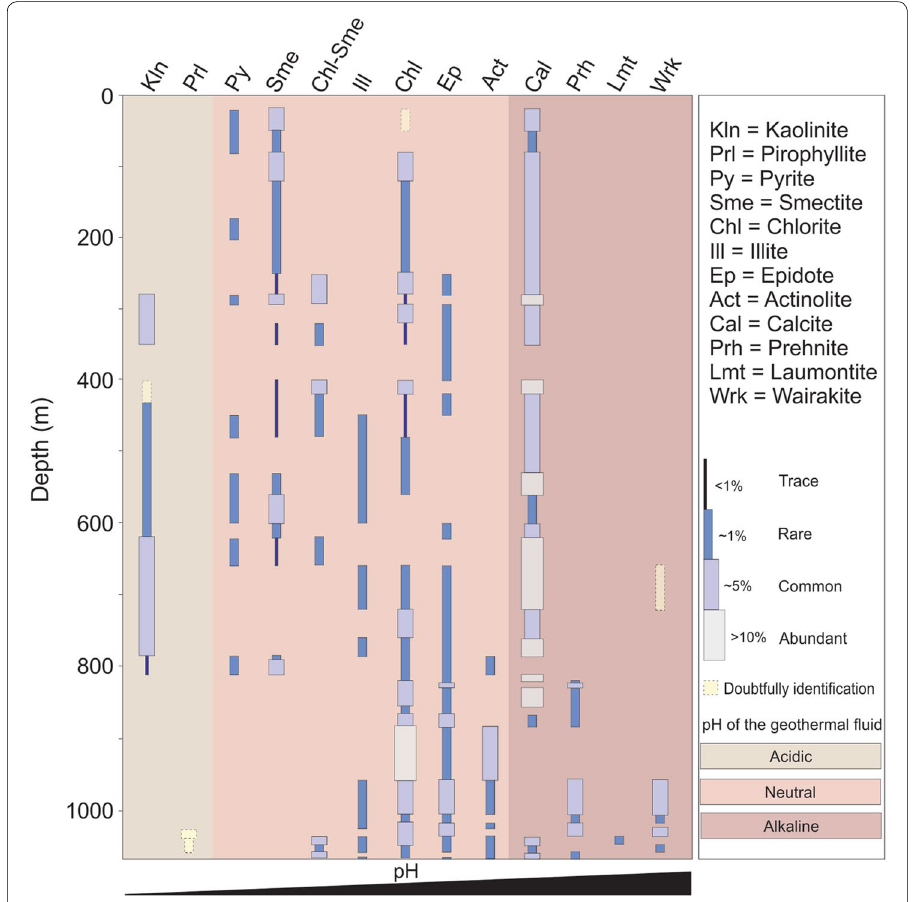
Fig. 5 Profile of the hydrothermal alteration minerals from the COP-3 well (JICA 1992). Minerals grouped according to the pH of the geothermal fluids, from acid to alkaline, based on Hedenquist et al.